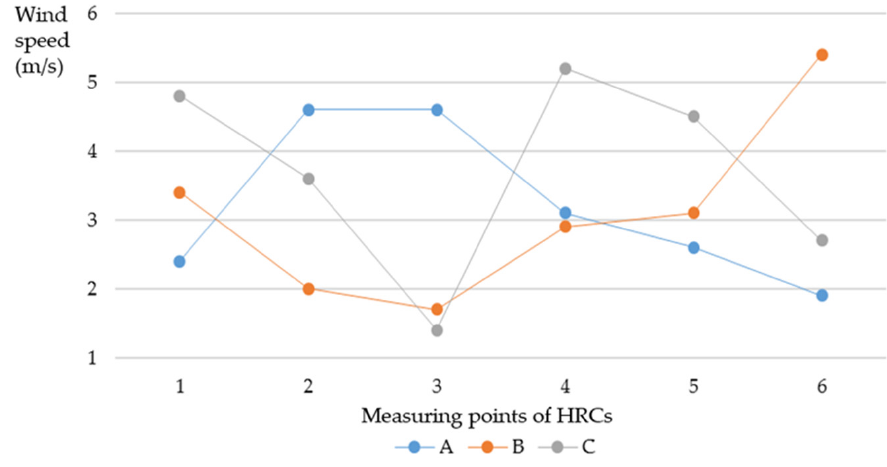
Figure 11. The measured average wind speed at each monitoring point within each HRC. In HRC B, the wind speed differed significantly among the measuring points. The wind speeds at points 1 and 2, located in the entrance/exit areas, reached 3.4 and 2 m/s, respectively. The wind speed at point 3 was the lowest at 1.7 m/s. Due to the blocking effect of the surrounding environment, the wind speeds (2.9 and 3.1 m/s, respectively) at points 4 and 5, both of which were close to the mountains, were comparable to those at points 1 and 2. The wind speed at point 6 was the highest at 5.4